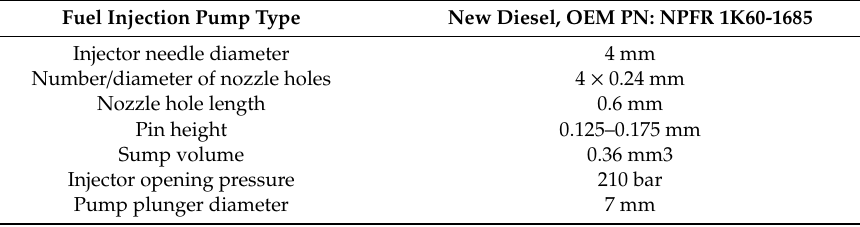
Table 5. Ruggerini RF91engine injection system specifications.